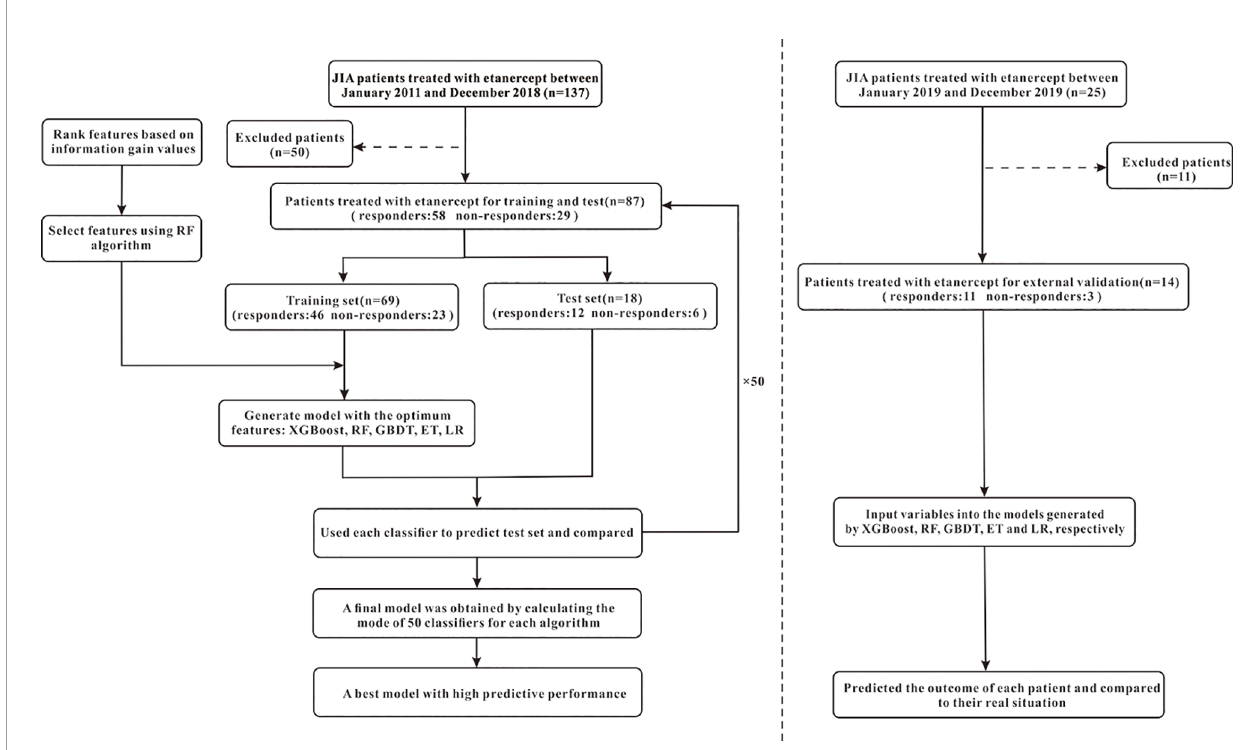
FIGURE 2 | The fl owchart of model generation and validation. The left side of the dotted line is the process of model generation, while the right side is the external validation of the model. XGBoost, extreme gradient boosting; RF, random forest; GBDT; gradient boosting decision tree; ET, extremely randomized trees; LR, logistic